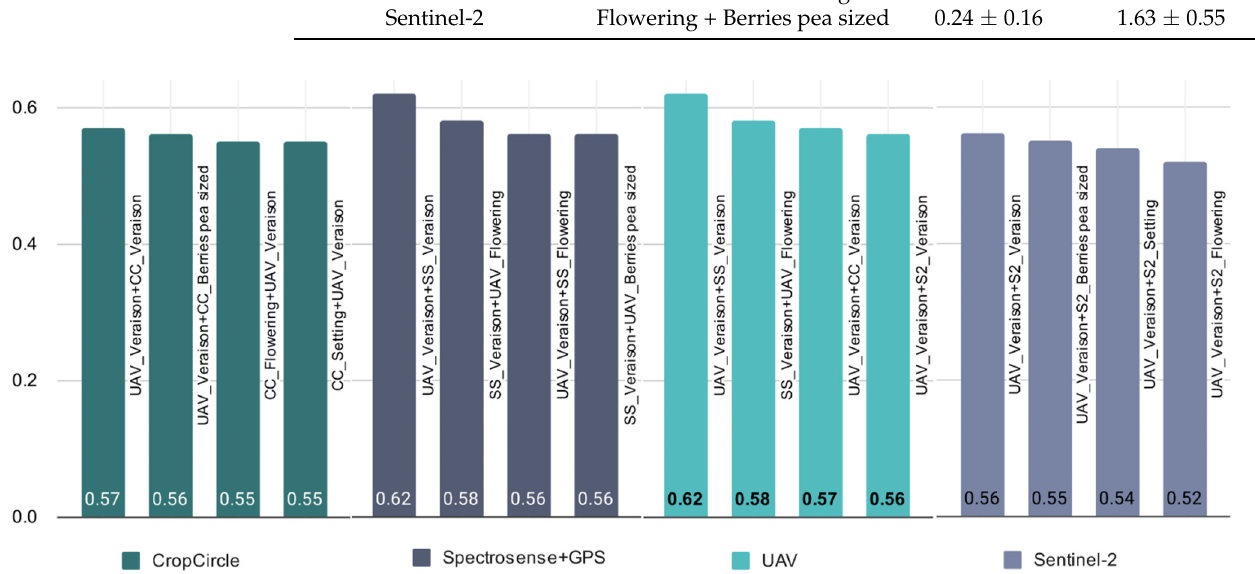
Figure 5. Given a specific sensor (CropCircle, Spectrosense + GPS, UAV, Sentinel-2), selected best performed R 2 for the combination of sensors and growth stages over the two growing seasons (2019 and 2020), using AutoML to assess their performance in evaluating grape quality attributes (legend as for Table 2).